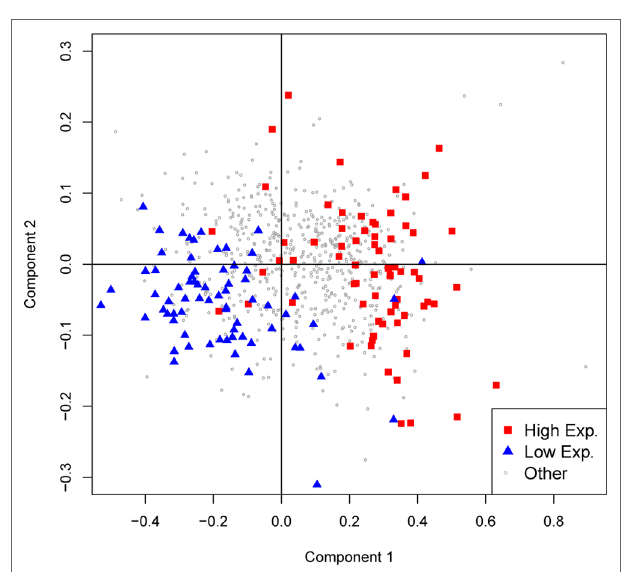
FIGURE 5 | GC variation and expression level in S. mansoni. The first two axes of a principal component analysis on codon frequencies are plotted. Genes with expression levels above the 90 th percentile or below the 10 th percentile are colored red and blue,